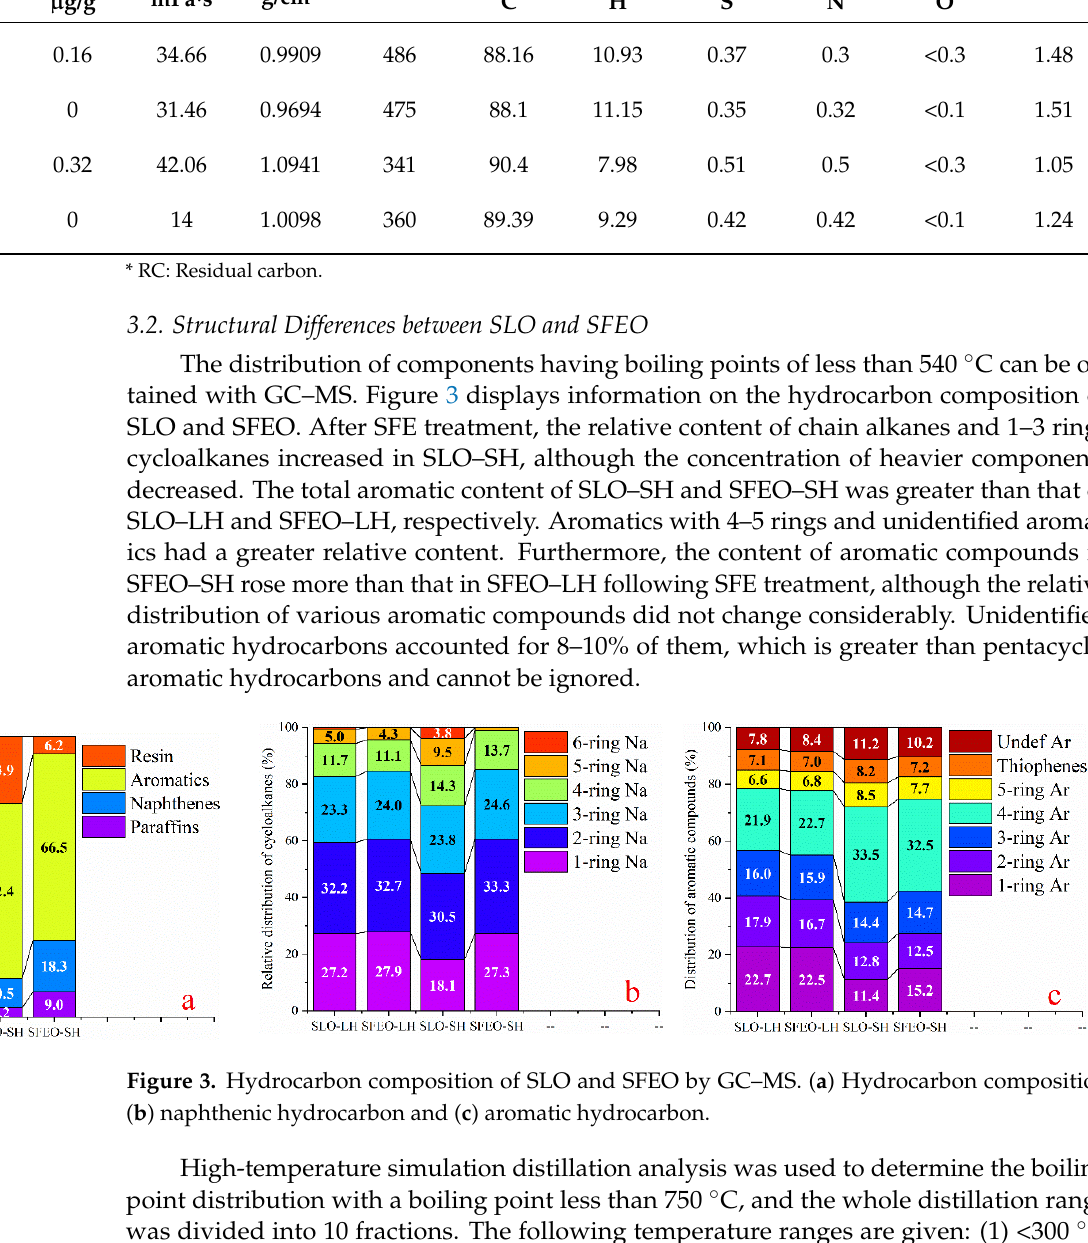
Table 3. Basic properties data of two kinds of SLO and SFEO.